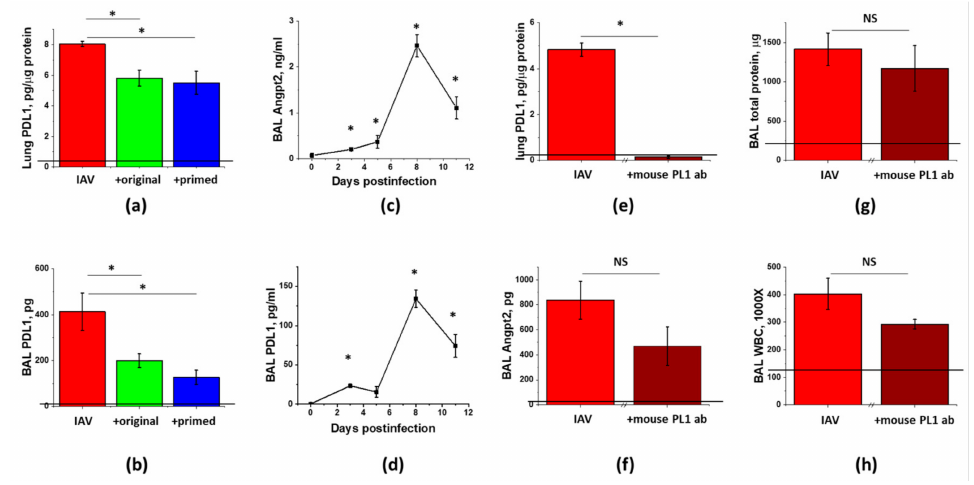
Figure 8. Levels of PDL1 and Angpt2 are affected by IAV infection and ASC-CS therapy in a similar manner; however, late stage ablation of PDL1 does not significantly attenuate Angpt2 levels or lung injury. Mice from Figure 6 (IAV + PBS—red; IAV + original ASC-CS—green; IAV + primed ASC-CS— blue) were terminated at Day9 to analyze for lung ( a ) and BAL ( b ) PDL1 levels. Mice from Figure 1 were analyzed for BAL Angpt2 ( c ) and PDL1 ( d ) levels. Male C57Bl/6 mice received intranasal administration of IAV H1N1 PR8 (800 pfu/mouse) on Day0 ( e – h ). On Day6 and 8, IAV mice were SQ injected with 8 mg/kg of anti-mouse PDL1 antibody (brown columns), or an equivalent volume of PBS (red columns). Lung tissue and BAL fluids were collected on Day9 to analyze for lung PDL1 levels ( e ), BAL Angpt2 levels ( f ), BAL total protein ( g ) and WBC ( h ). n = 3–8 per group, presented are mean +/ − SEM. Lines indicate levels of analytes detected in control (saline to lung) mice. * for p < 0.05 by t -test with Welch correction (unequal variances) between groups indicated ( a , b , e – h ) or with control group, plotted as Day0 ( c , d ). NS - differences between the groups are not